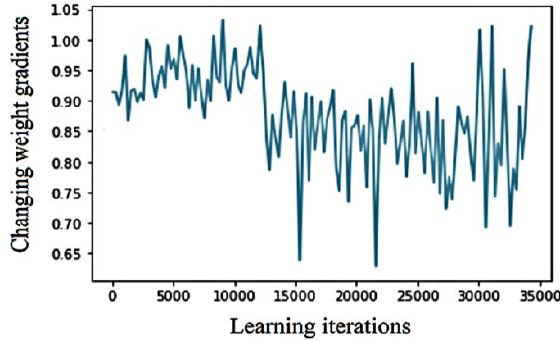
Fig. 2. Graph of uneven changes in the gradients of weights of an artificial neural network .